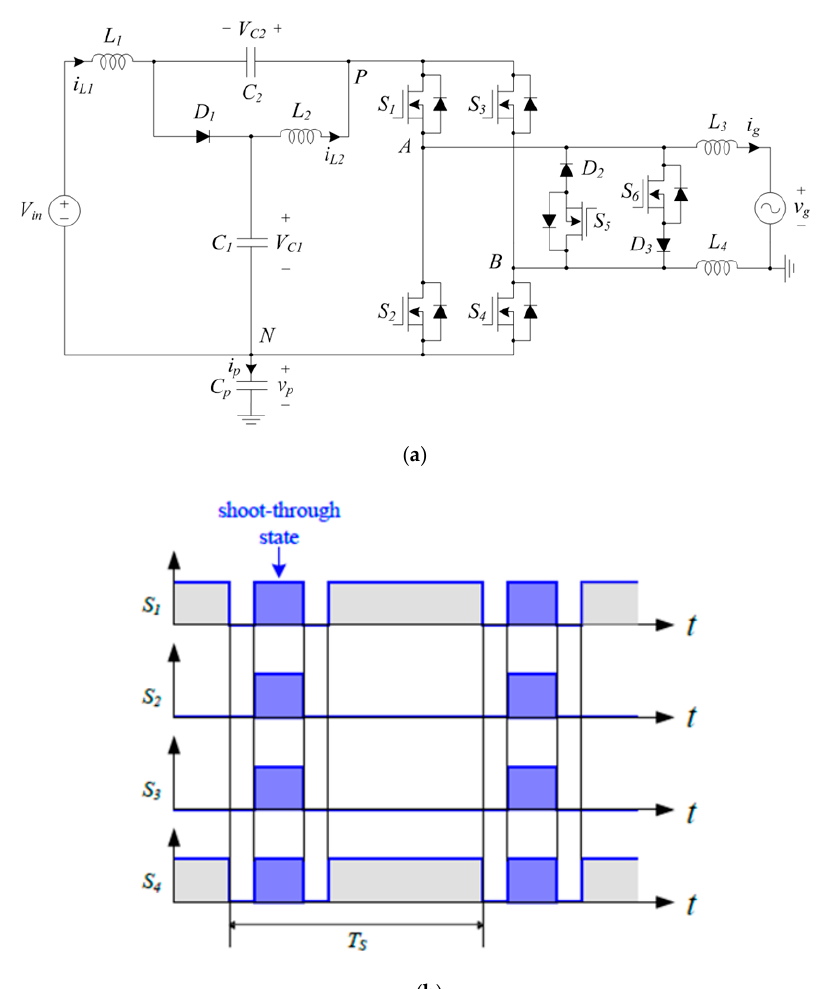
Figure 11. Circuit and signal diagrams of the inverter in [15]: ( a ) circuit diagram; ( b ) signal diagram for S 1 ~ S 4 .